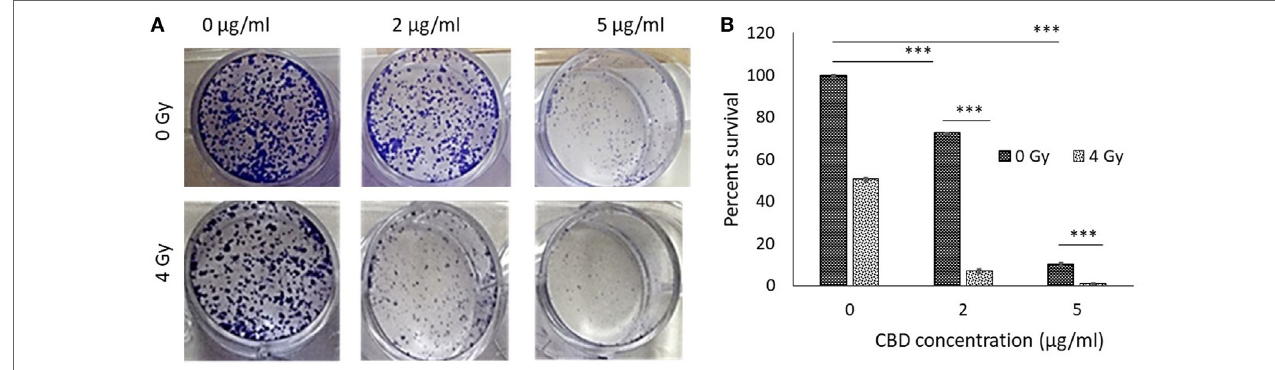
FigUre 2 | In vitro antitumor effect of cannabinoid (CBD). (a) Clonogenic assay results comparing results for different CBD radiotherapy (RT) dose combinations. (B) Perspective results of synergistic outcomes when combining RT at 4 Gy with different CBD